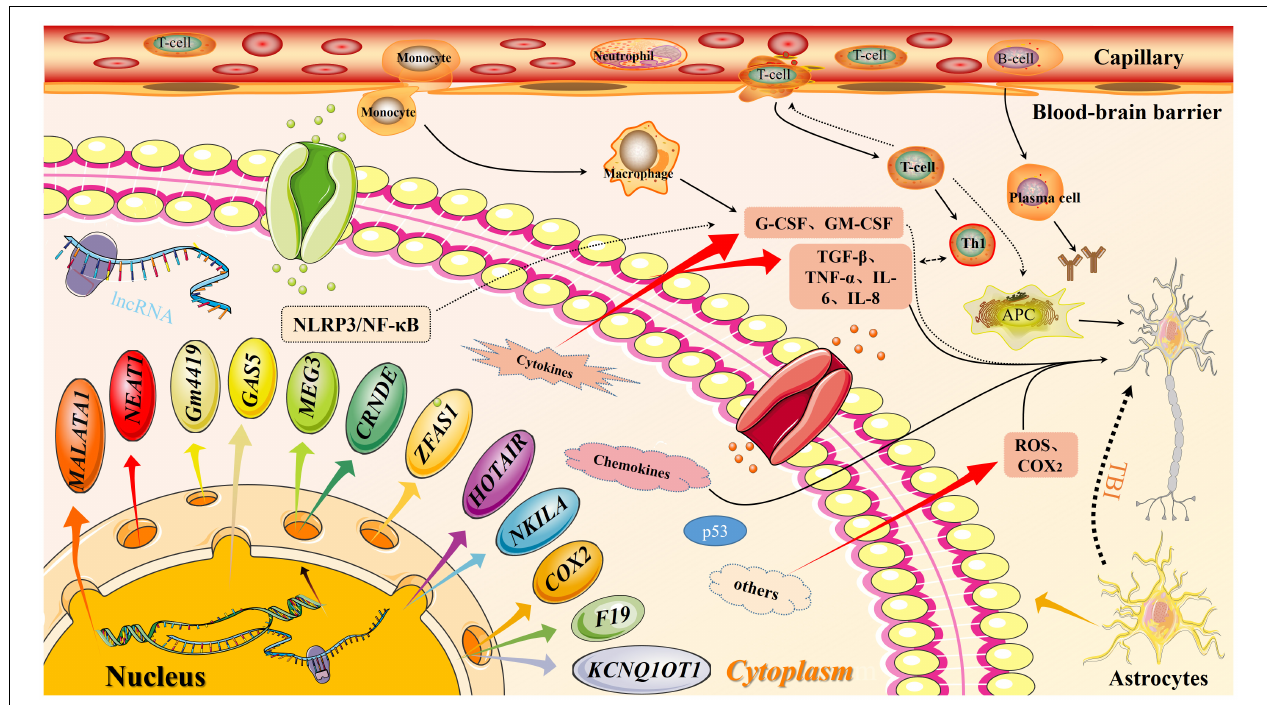
FIGURE 3 | Long non-coding RNA (lncRNA) molecular pattern diagram in traumatic brain injury (TBI). In traumatic brain injury, the expression of lncRNA downstream molecules increases, which activates the inflammation pathway. At the same time, the permeability of the blood-brain barrier increase, thereby releasing inflammatory factors. Both factors will affect secondary brain